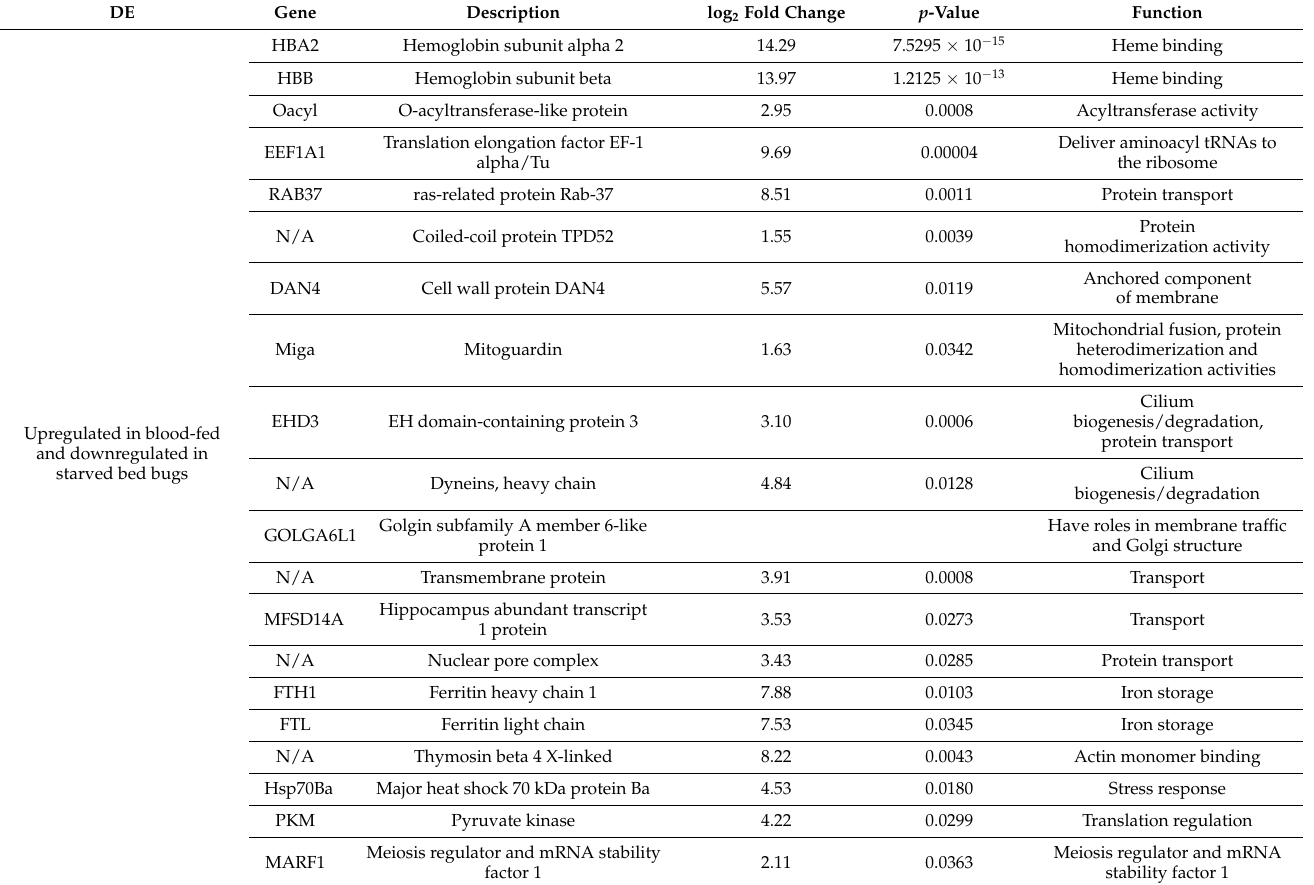
Table 3. DEGs in blood fed and starved tropical bed bugs.